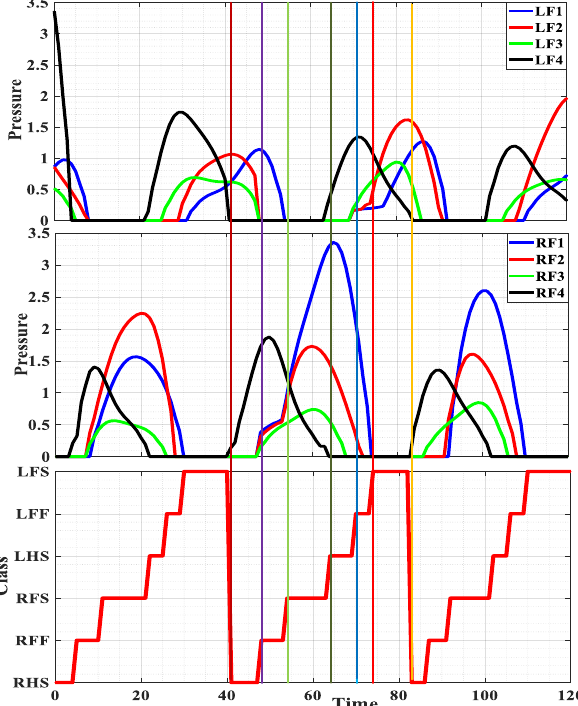
Figure 10. Gait phase egmentation based on plantar pressure(the red line in the figure represents the duration of each stage, and the vertical color line is the dividing line of each stage ) .